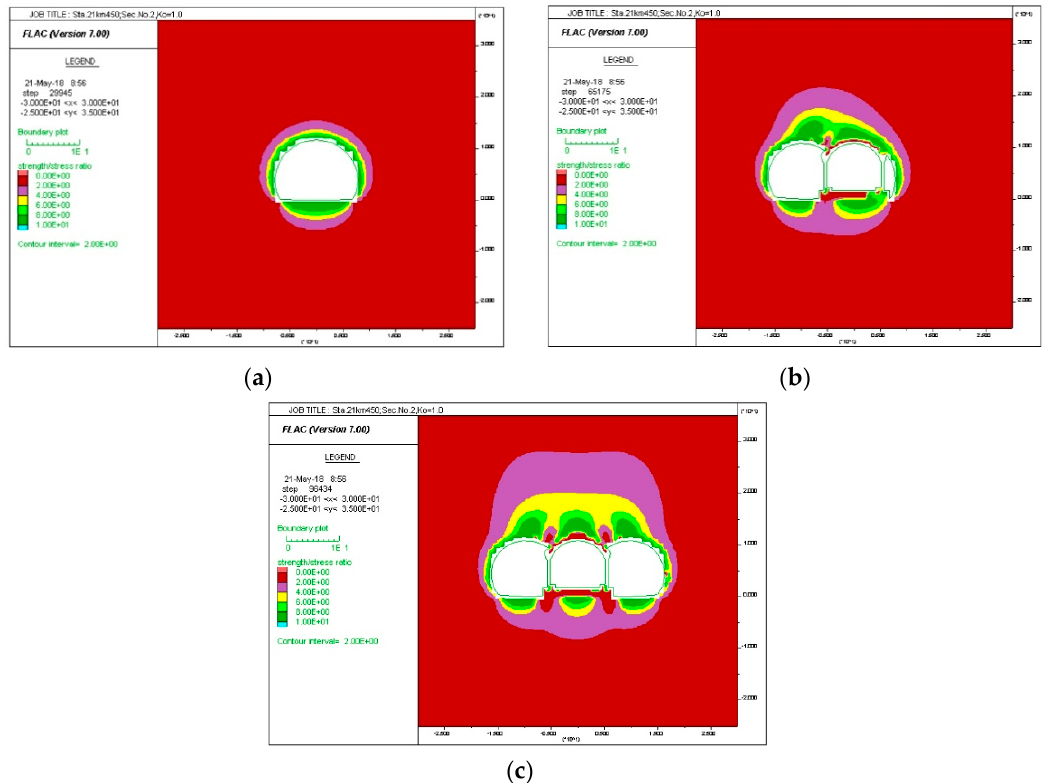
Figure 15. Rock load estimation based on the stress variable of 10% according to the construction steps: ( a ) excavation of the central tunnel, completed in step 6; ( b ) excavation of the left tunnel, completed in step 13; ( c ) excavation of the right tunnel, completed in step 19.